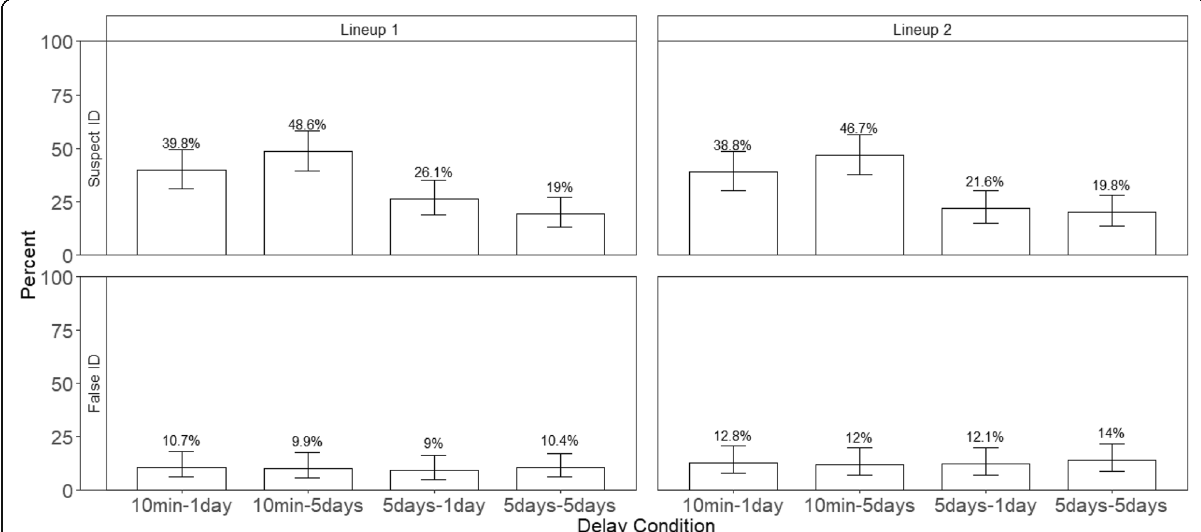
Fig. 5 The top panels show the percentage of suspect IDs and the bottom panels show the percentage of false IDs in Experiment 2. Error bars represent 95% confidence